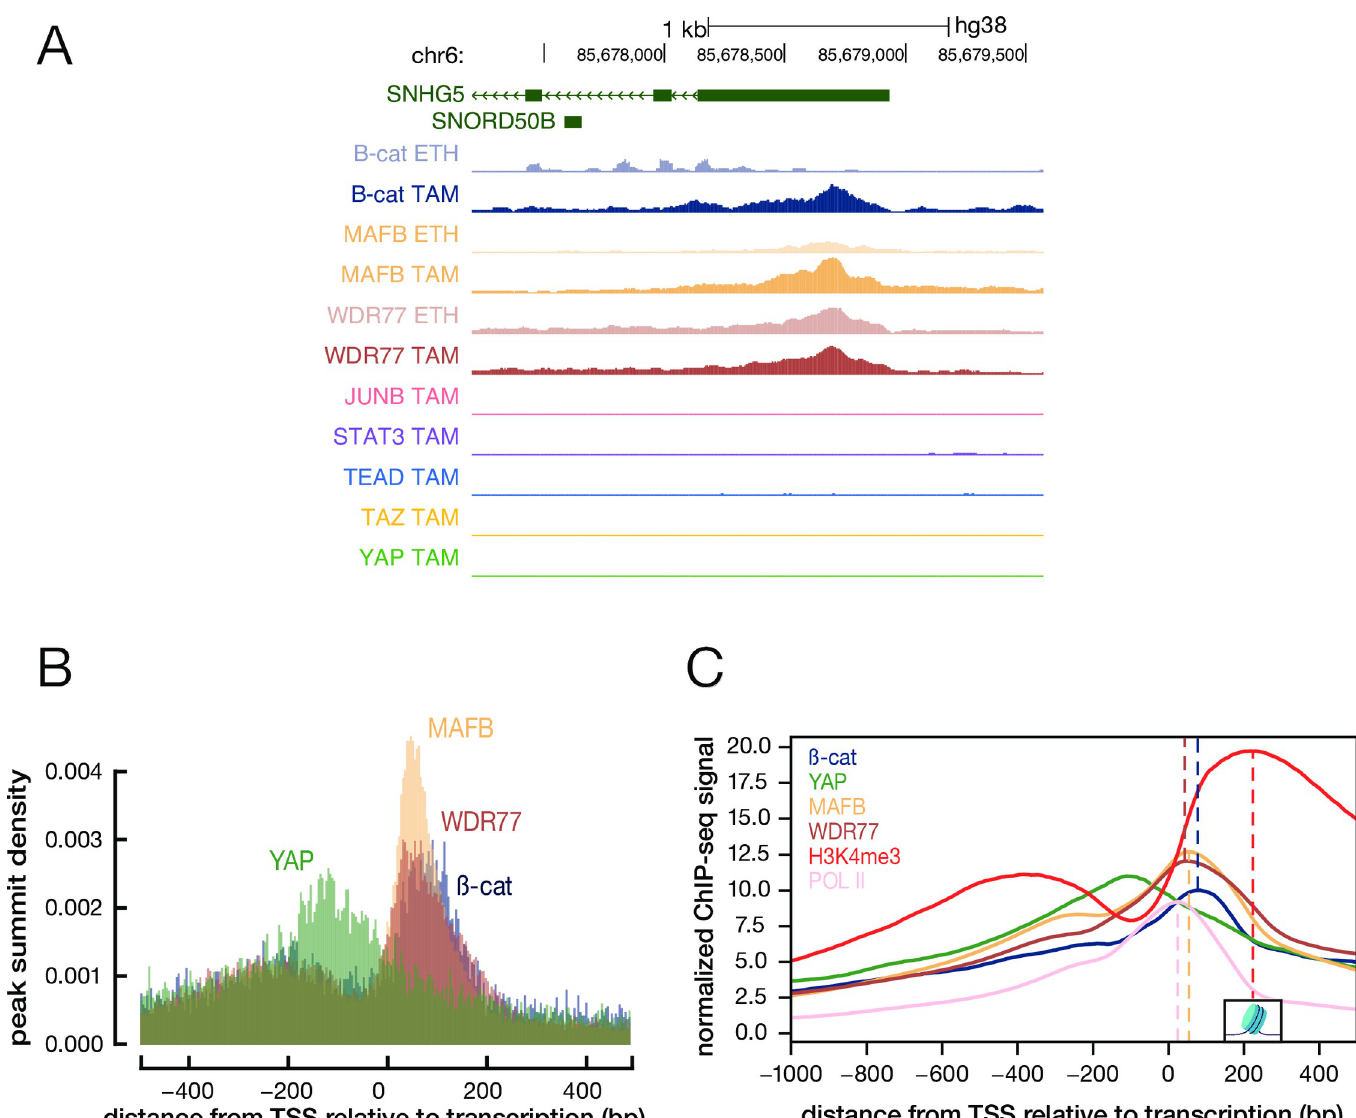
Fig 4. Many ß-catenin/MafB/WDR77 sites are located between paused Pol II and +1 nucleosome. (A) Genome browser view of ChIP-seq signals of the indicated proteins in non-transformed (ETH) or transformed (TAM) calls at an example locus ( SNHG5 ). (B) Histogram of ChIP-seq peak summits around the TSS in transformed cells. (C) Aggregated ChIP-seq signal with the regions between -1000 and +500 with respect to the TSS. Dashed line shows the summit (position with the highest aggregated signal), and the +1 nucleosome is centered at the summit of the H3K4me3